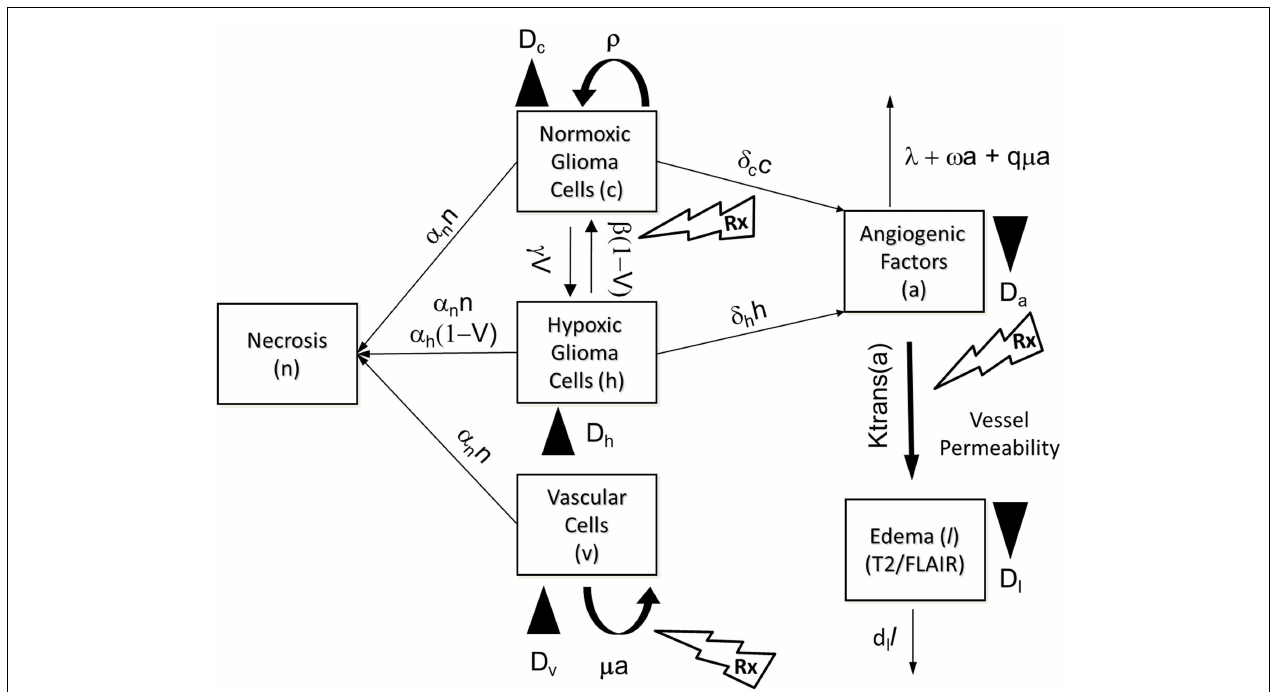
necrotic cells. Both hypoxic and normoxic cells release angiogenic factors into the extracellular space which recruit additional vasculature to increase the levels of oxygen.The angiogenic factors are removed from the system by interaction with vascular cells or natural decay.The local levels of angiogenic factors are indicative of the local degree of vessel permeability. Edematous liquid exits the vasculature where the permeability, K trans ( a ), allows and enters the extracellular space where it diffuses and will be removed at rate d l